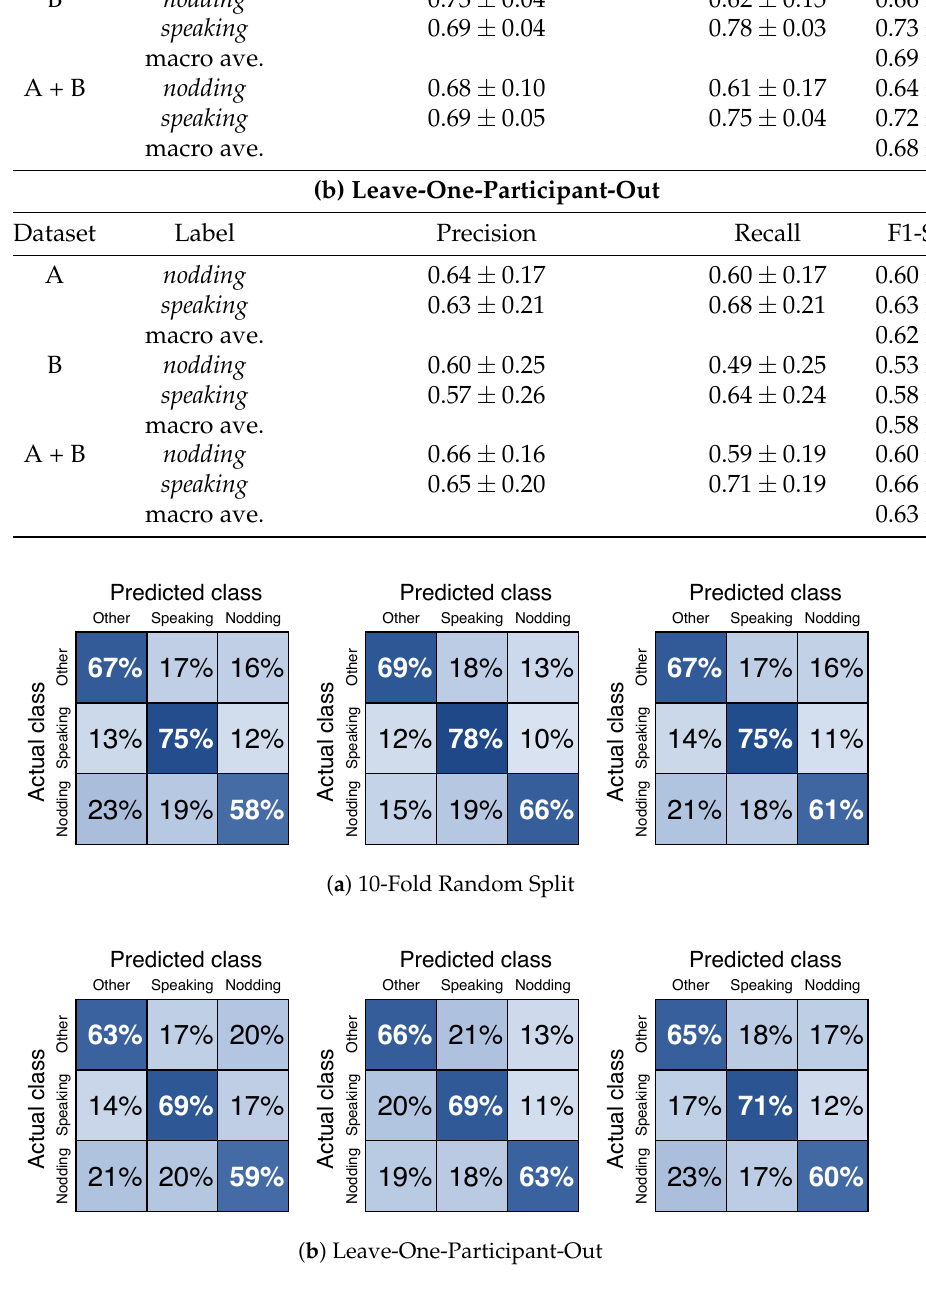
Figure 8. Confusion Matrix of nodding , speaking , and other . Using facial points and head rotation data as features. Down sampling was applied. Only offline meeting datasets were used. From the left figure, the result is extracted from M3B Corpus [46] (Dataset A), Kyushu University (Dataset B), and both (Dataset A + B). Datasets are split into two patterns: ( a ) 10-fold random split and ( b ) leave-one-participant-out. Random forest is used as the machine learning